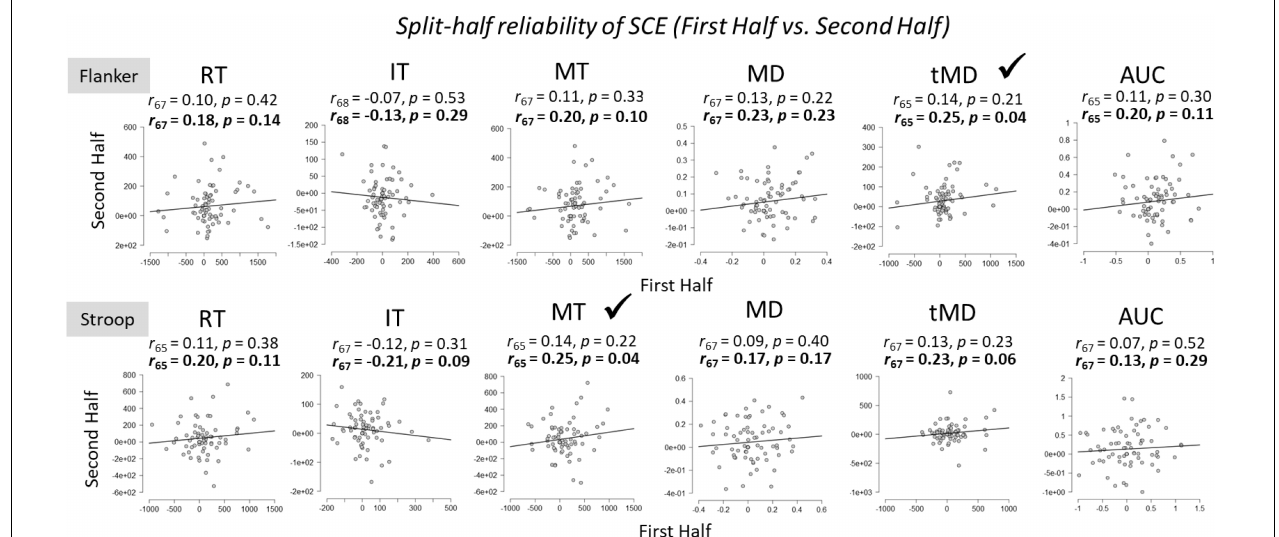
FIGURE 4 | Within-task split-half (first half vs. second half of trials) reliabilities for Flanker and Stroop tasks. RT, Reaction Time; IT, Initiation Time; MT, Movement Time; MD, Maximum Deviation; tMD, Time to Maximum Deviation; AUC, Area Under the Curve. Significant reliability (i.e., positive Pearson r correlation coefficients) after Spearman-Brown prophecy correction are marked with a check mark. Un-bolded values above the graphs represent Pearson r correlation coefficients without correction, and bolded values represent Pearson r correlation coefficients after Spearman-Brown